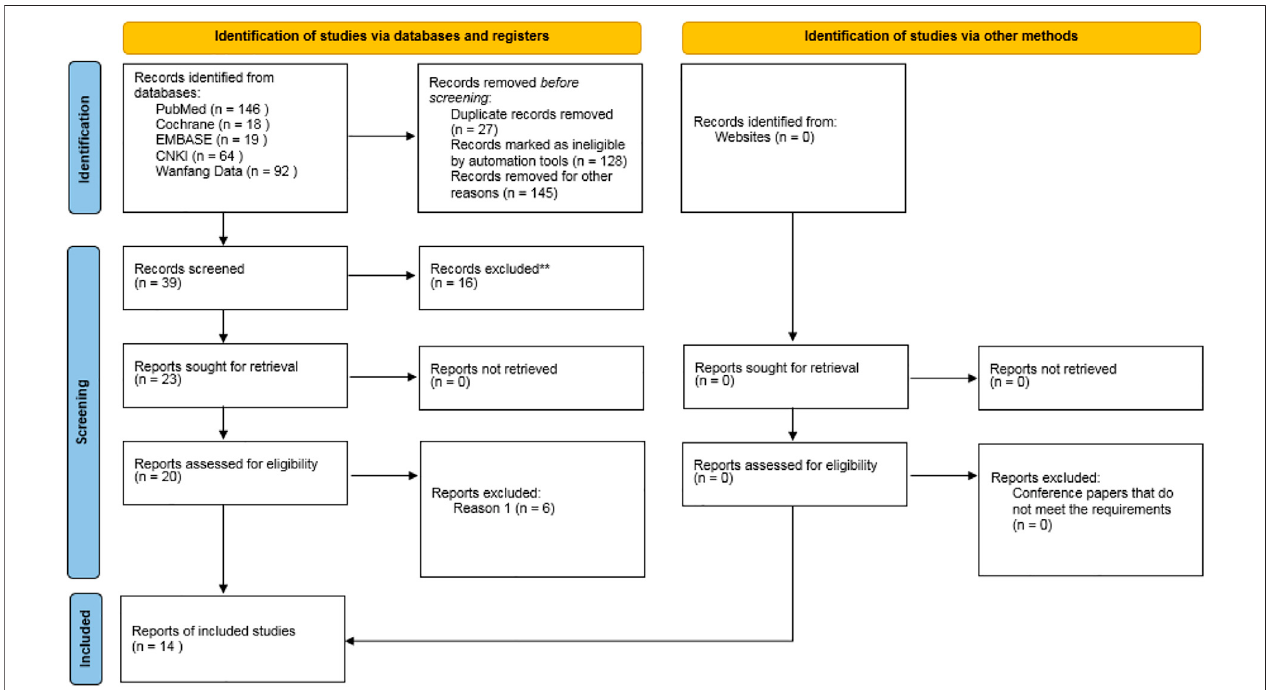
FIGURE 1 | Flow chart of literature screening process and